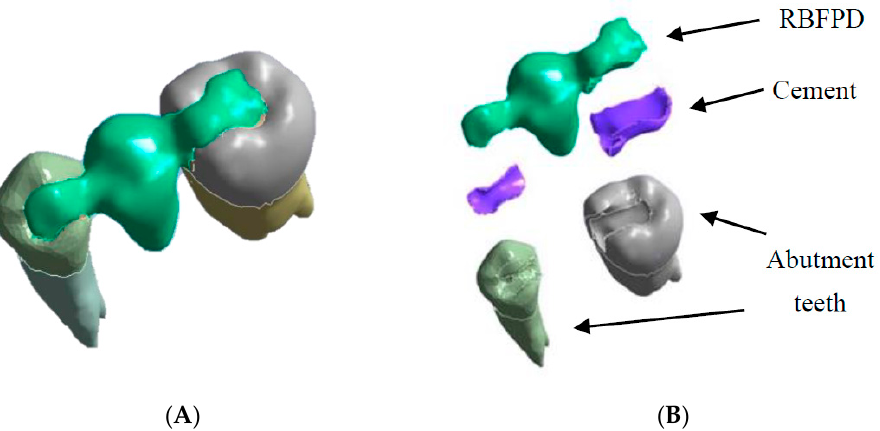
Figure 3. Geometric model of RBFPD used for numerical analysis: ( A ) bridge in situ; ( B ) elements presented separately.